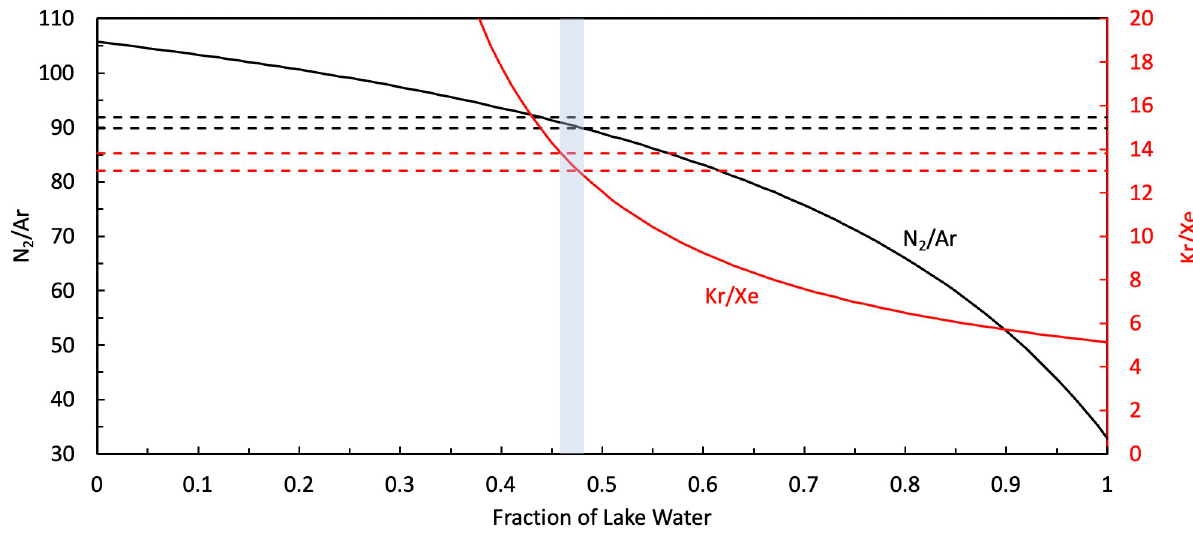
Fig 8. The calculated ratio of N 2 to Ar in the bubbles in the spring as a function of the fraction of the source water that comes from air-saturated fresh water lakes. The other source is gas trapped in glacier ice carried into the springs. The dashed lines show the values of N 2 /Ar based on measured gas values in the spring water and the bubbles (lower line). The upper line shows the ratio for and the measured gas values in the spring water and the assumption of equilibrium in the bubbles in the spring. The uncertainty in the N 2 /Ar measurements is ± 3%, comparable to the spacing between the two dashed lines (2%). The red line and the right-hand scale show the corresponding results for the ratio of Kr/Xe. The spacing between the red dashed lines is larger, ~ 6%. For both gas, ratios the fraction of liquid water that fits the data is 0.47 ± 0.01, shown by the blue-shaded region.